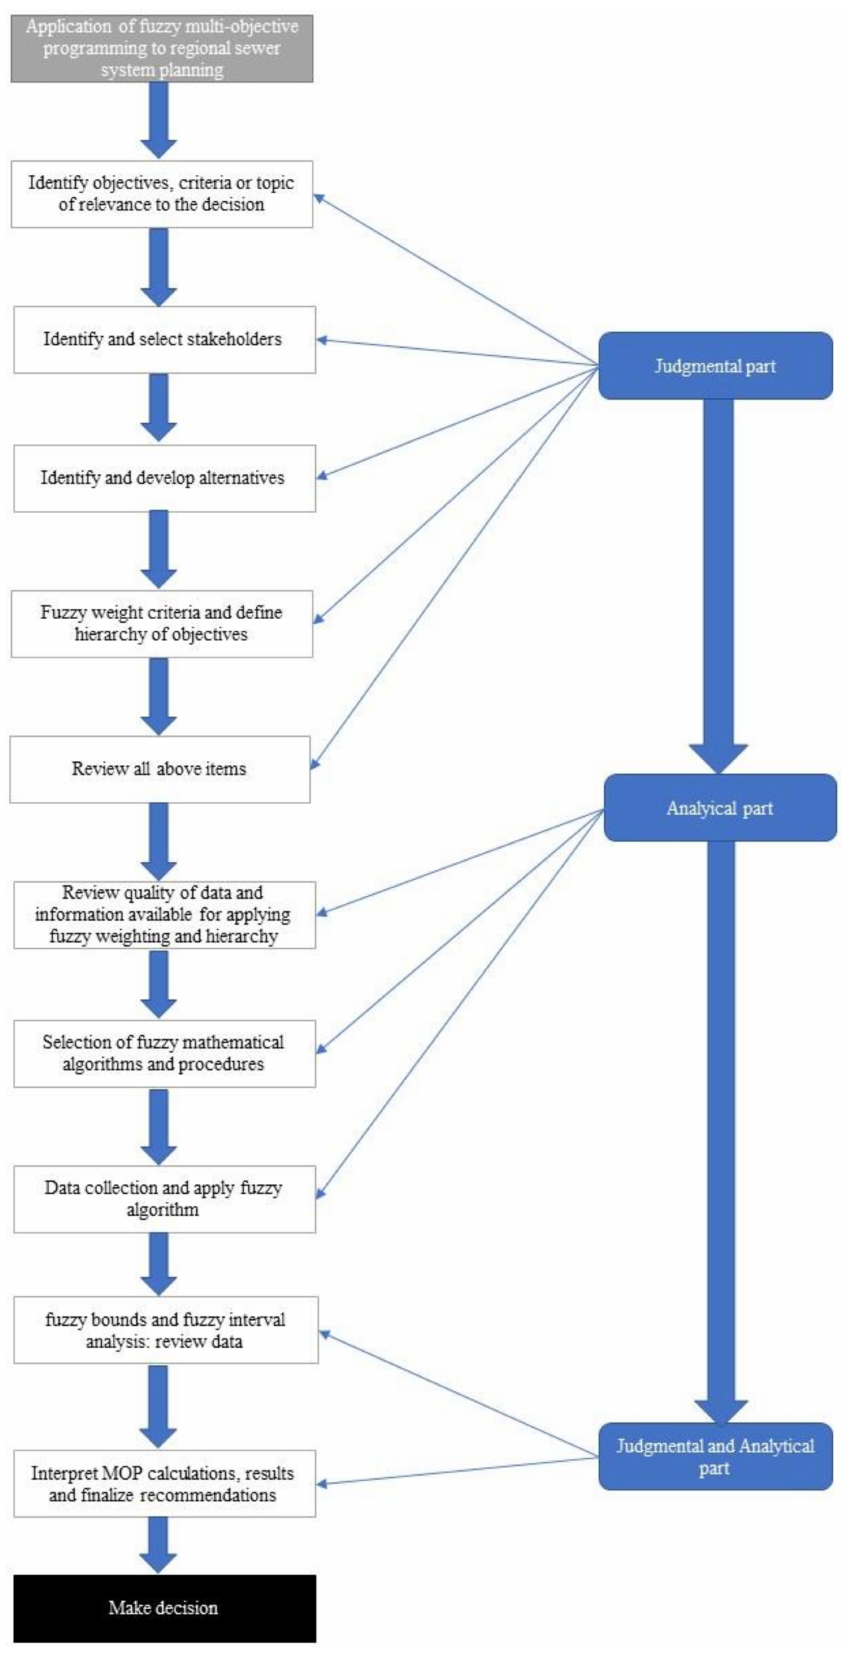
Figure 2. Flow chart of experimental